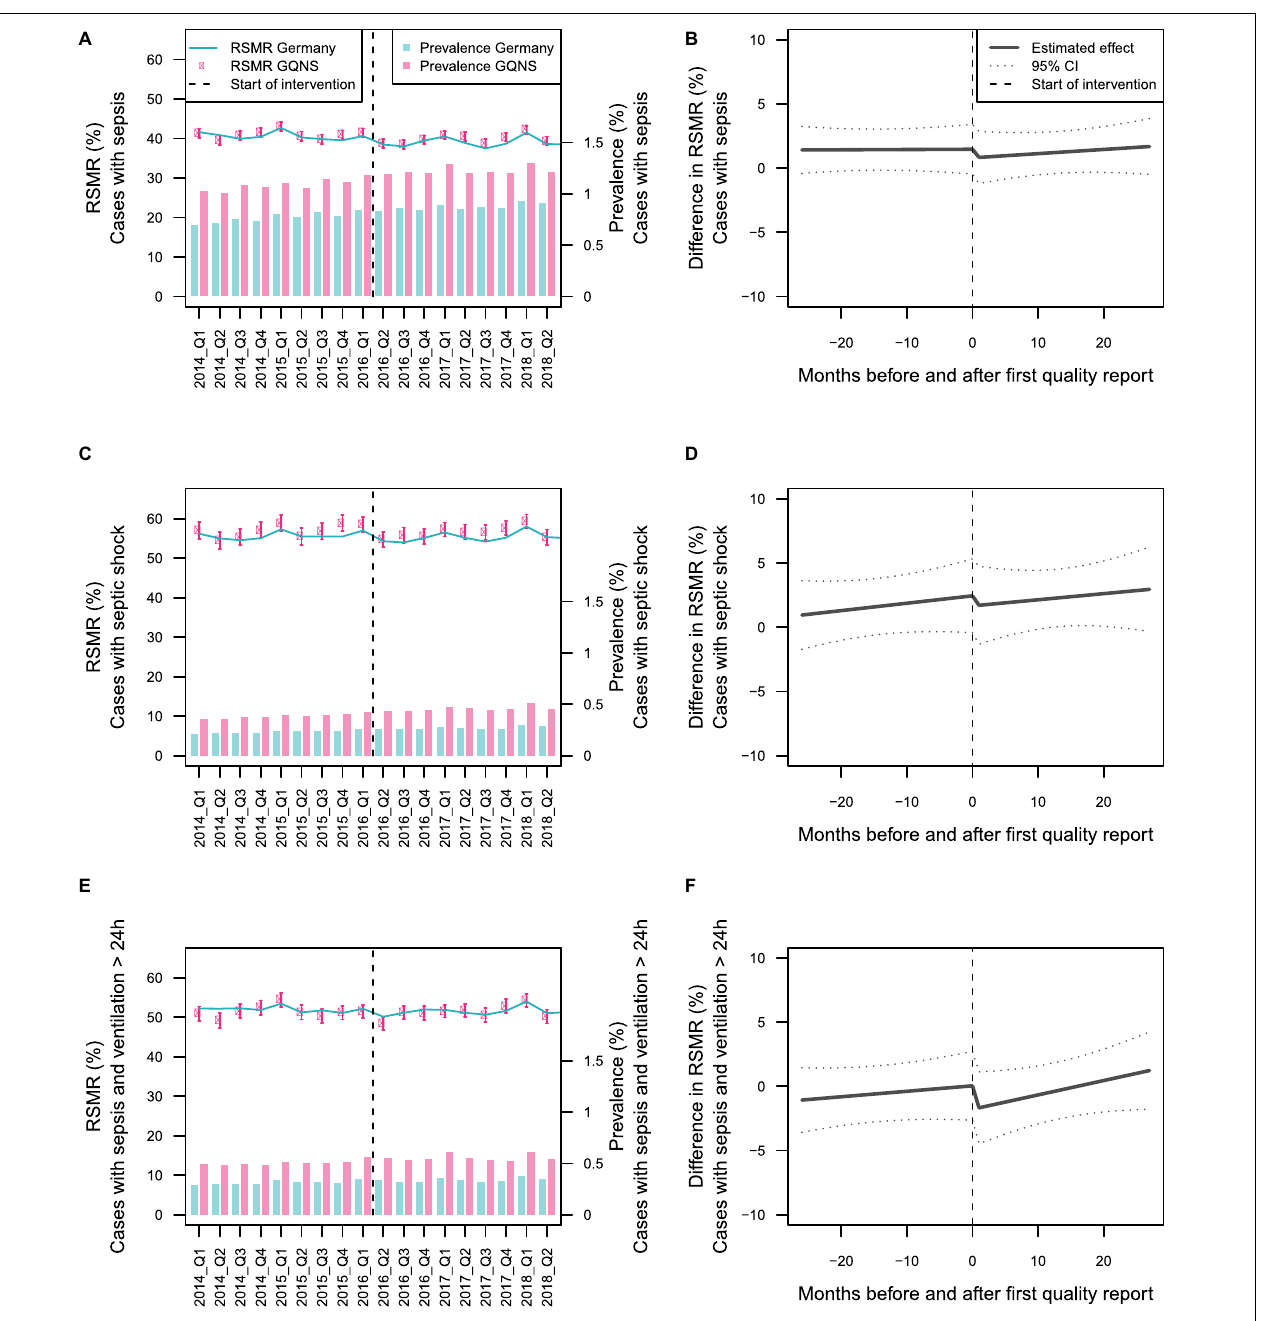
FIGURE 3 | Depiction of the effect of hospitals’ participation in the GQNS. Panels (A,C,E) present the descriptive changes in prevalence and risk-standardized mortality rate (RSMR) for patients with sepsis, septic shock, and sepsis with mechanical ventilation > 24 h. The beginning of the intervention phase is defined uniformly by April 2016 for all hospitals. Panels (B,D,F) depict the slopes before and after the beginning of the intervention, as well as the change in level at the beginning of the intervention with 95% prediction limits as estimated from interrupted time series analyses on the monthly RSMR-difference between GQNS hospitals and the national DRG-statistics. The beginning of the intervention phase is defined individually for each hospital by the date the first quality reports were provided to this hospital.